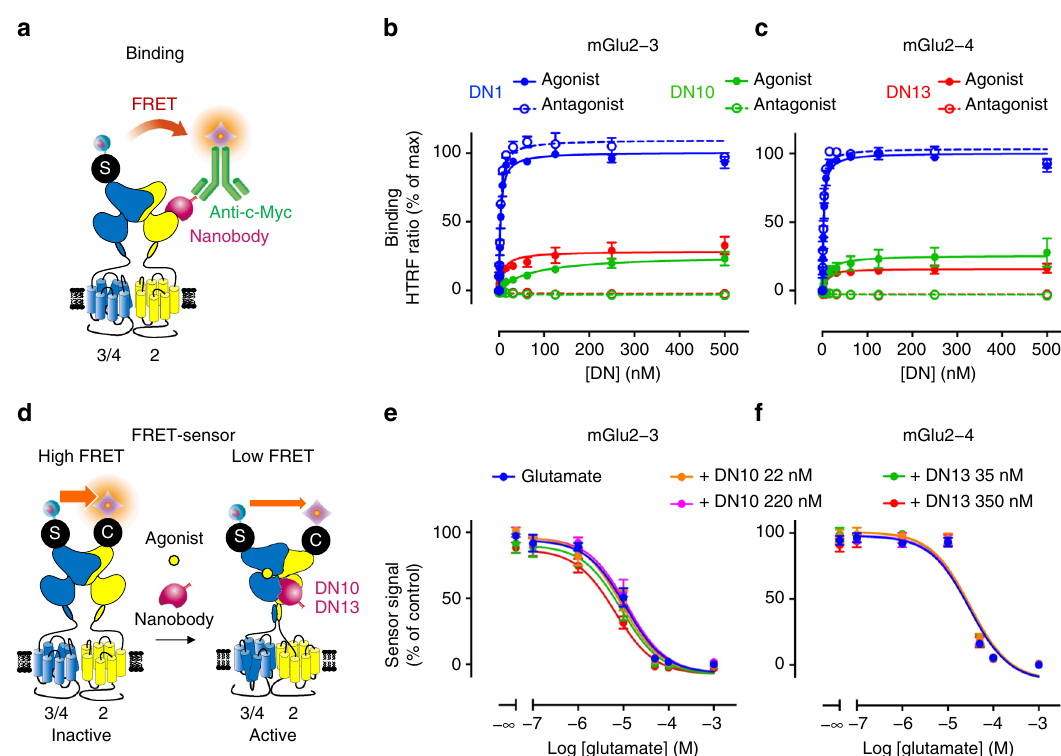
Fig. 4 Binding and effect of DN10 and DN13 on mGlu2 containing heterodimers. a Scheme illustrating the approach used to detect binding of the c-Myc- tagged nanobodies on mGlu2 heterodimers containing either SNAP-mGlu3 or SNAP-mGlu4 labeled with SNAP-Lumi4-Tb. b and c TR-FRET signal measured as a function of the concentration of nanobody on cells expressing mGlu2 and SNAP-mGlu3 ( b ) or SNAP-mGlu4 ( c ). d Scheme illustrating the approach used to speci fi cally detect the activation of mGlu2-3 or mGlu2-4 heterodimers, as based on the co-expression of SNAP-mGlu3 or SNAP-mGlu4 with CLIP-mGlu2, labeled respectively with SNAP-Lumi4-Tb and CLIP-Green. e and f TR-FRET signal measured as a function of the concentration of glutamate on cells expressing CLIP-mGlu2 and SNAP-mGlu3 ( e ) or SNAP-mGlu4 ( f ). Data are expressed as percent of the signal obtained with DN1 in the presence of agonist ( b , c ), or percent of the maximal agonist-induced change in FRET ( e , f ). Data are mean ± SEM of 3 independent experiments